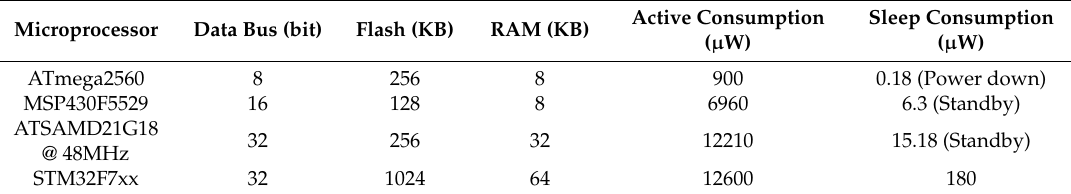
Table 3. Typical microprocessor modules and